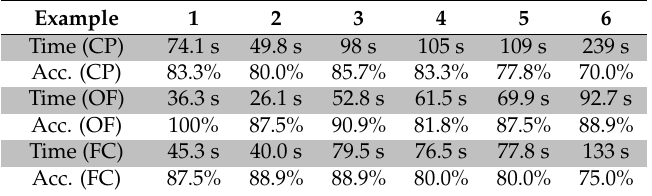
Table 4. Timings and accuracies for FOI identification with the CP, OF, and FC